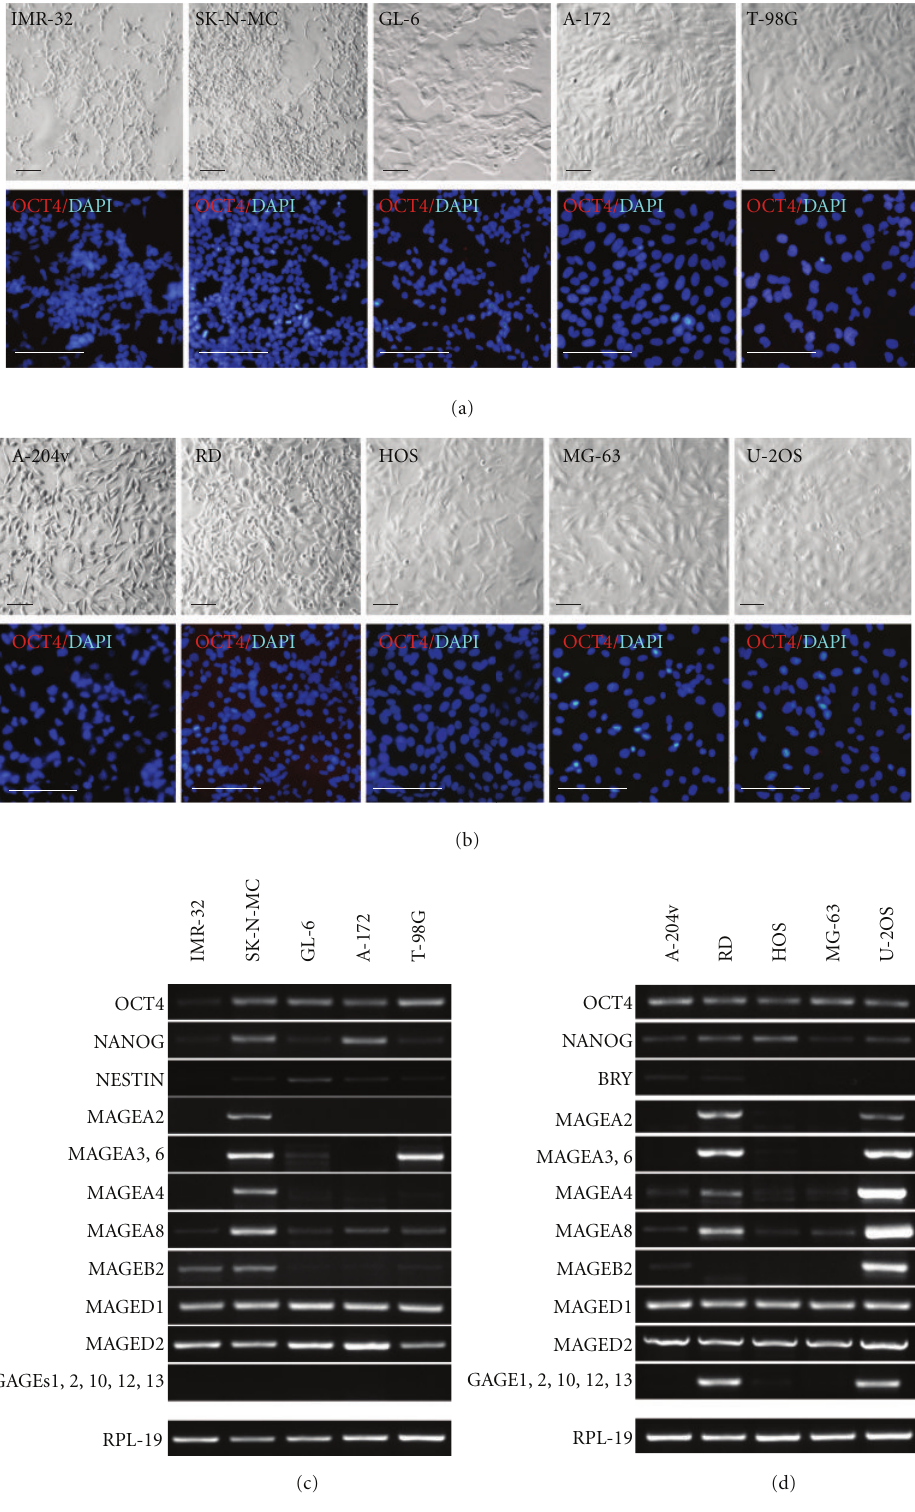
Figure 4: CTAs in cancer cell lines derived from tissues of neuroectodermal and mesodermal origin. (a) Cell morphology of neuroblastomas and glioblastomas and immunostaining of these cell lines by antibody against OCT4. Scale bar = 100 μ m. (b) Immunocytochemical analysis of OCT4 expression in rhabdomyosarcoma and osteosarcoma cell lines. Scale bar equal 100 μ m. (c) CTA expression profiles of cancer cell lines of neuroectodermal and mesodermal